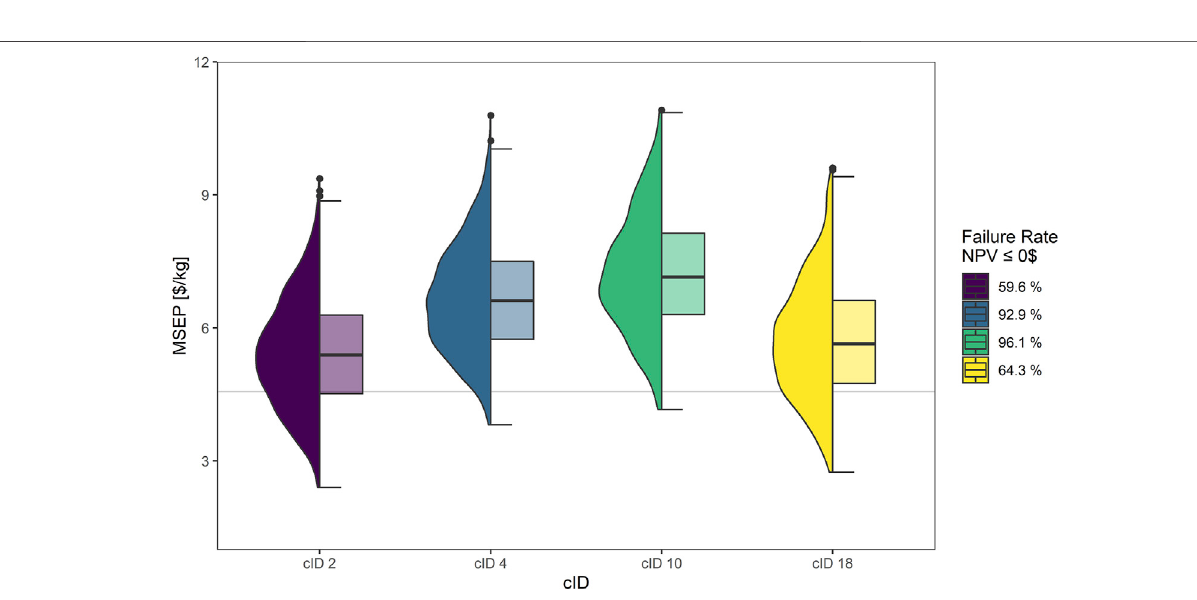
Frontiers in Chemical Engineering |